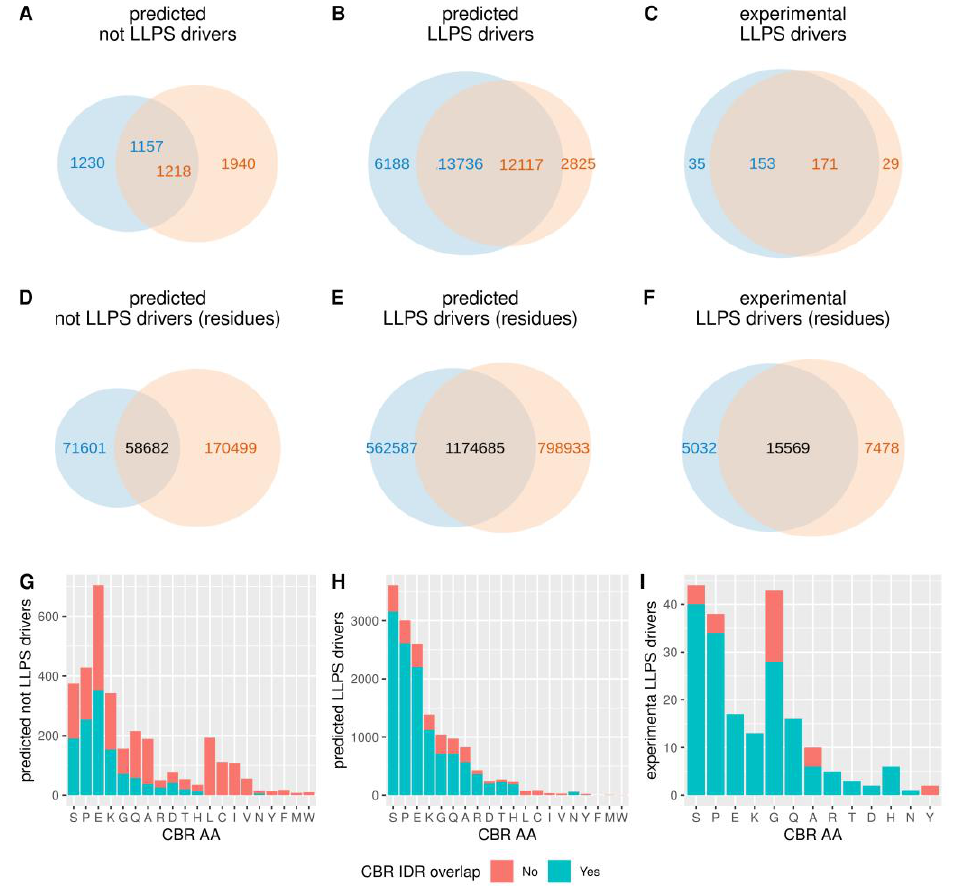
Figure 6. CBRs in LLPS drivers. Number of CBRs and their overlap to IDRs (predicted with IUPred2A) in human proteins predicted not to be LLPS drivers ( A ) or to be LLPS drivers ( B ) [34], or experimentally verified as LLPS drivers ( C ) (consolidated in the study of [33]) (see text and Methods for details). ( D-F ) Same as (A-C) but by number of residues. ( G-I ) show number of CBRs by type (ordered by global frequency) and their overlap to IDRs in predicted not LLPS drivers (G), predicted LLPS drivers (H) and experimental LLPS drivers (I).